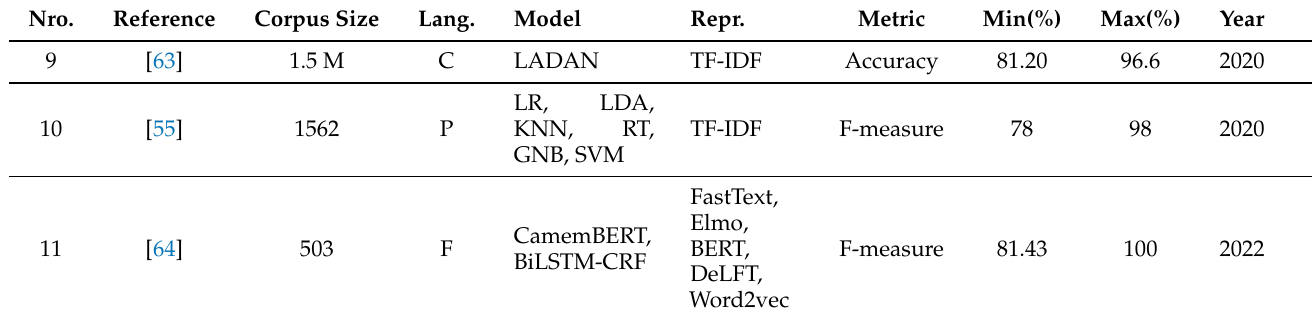
Table 6. Summary of ruling decision prediction in Public Law, where C = Chinese, F = French